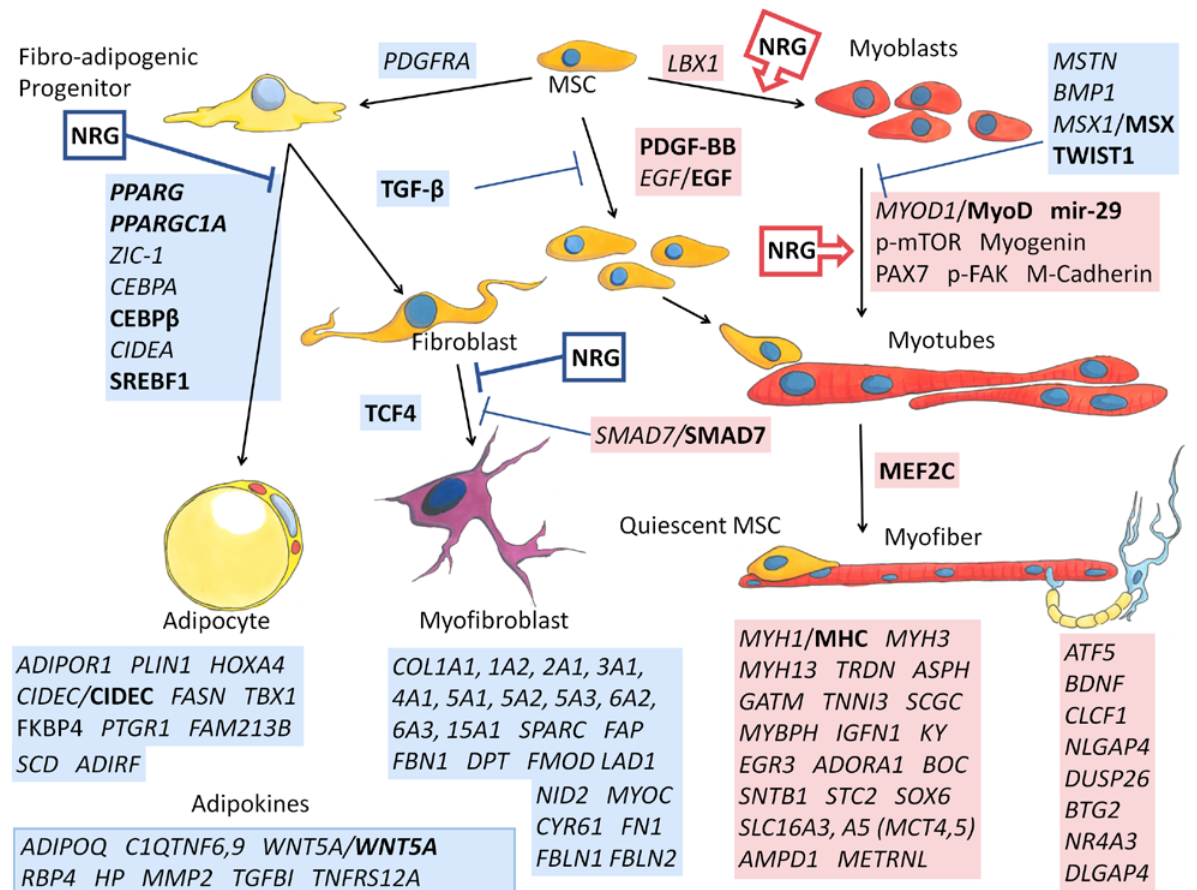
Figure 7. Depiction of inferred relationships of altered genes in GGF2-treated post-MI pigs. Transcripts that were up-regulated (highlighted in red) or down-regulated (blue) in intercostal muscle of neuregulin-treated pigs are italicized. Proteins identified as altered or activated based on Western blot analyses are also indicated. Bold indicates protein level inference based on functional analyses as described in the text. Known effects of neuregulin (NRG) on cell transitions based on published in vitro studies are indicated in red boxes with arrows (for promoting) or in blue (for inhibiting). Transcript abbreviations are official gene ( italic ) or protein symbols, and p- indicates phosphorylation (determined by Western blotting of lysates from NRG-treated myoblasts). MSC = mesenchymal stem cell; mir-29 = microRNA 29. Commissioned illustrations by Andrew Celso Gutierrez.